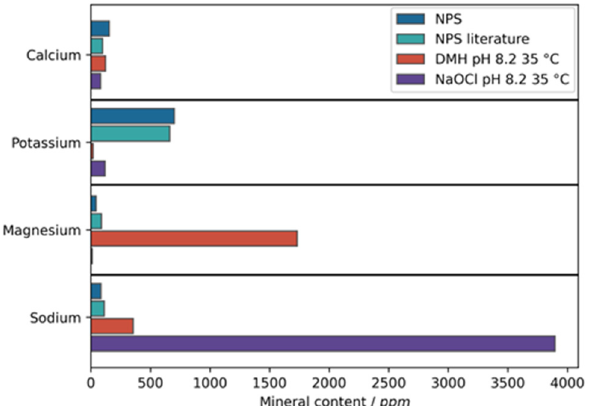
Figure 2. The mineral content of the native potato starch used in this paper (dark blue) compared to the NPS used by Noda et al., data from ref [8] (light blue), showing similar contents of all minerals. In red, the mineral content after oxidation by DMH at pH 8.2, at 45 °C and with 8.5 mol% -OCl is shown. In purple, the mineral content after oxidation by NaOCl at pH 8.2, at 35 °C and using 8.5 mol% -OCl is shown.